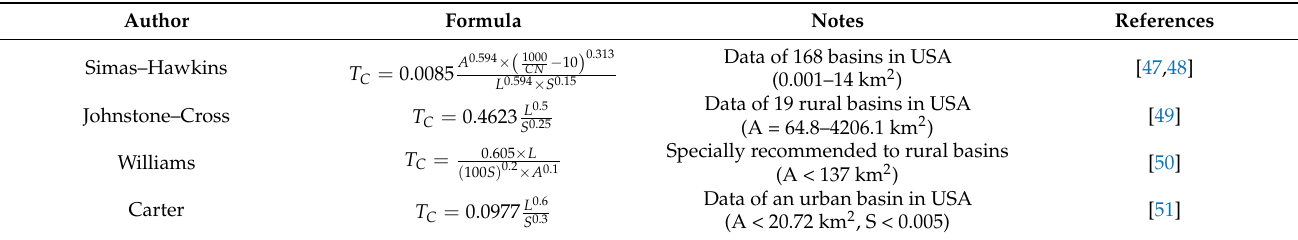
Table 5. List of formulas used for the estimation of the time of concentration